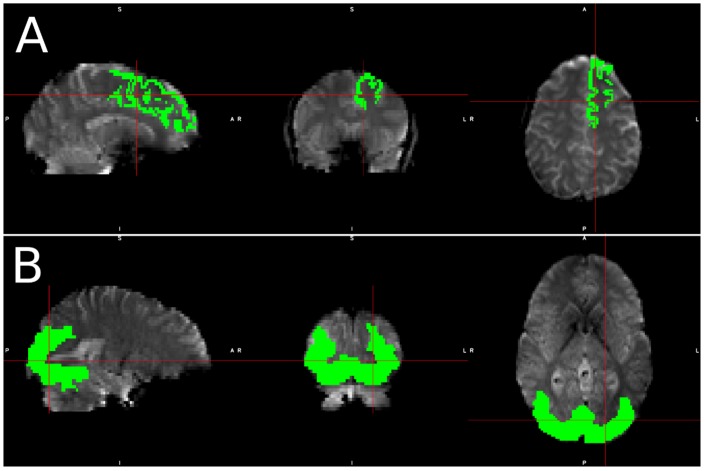
Visualization of spatial ROI’s used in analysis. Spatial maps for ROI’s used in (A) simulated data, which was identical for each simulated subject, and (B) Real data, in which the ROI varied slightly from subject to subject due to individual subject morphometry.